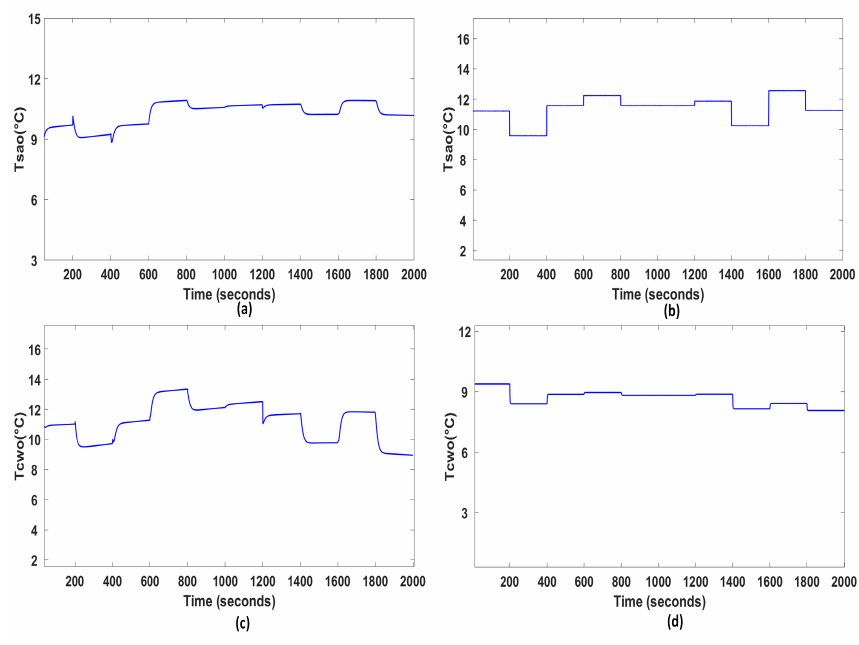
Figure 11. Output temperature results of, ( a ) supply air (Tsao) from the PID controller for the combination of steps reference of Zone 1 and Zone 2, ( b ) supply air (Tsao) from SMC for the combination of steps reference of Zone 1 and Zone 2, ( c ) cooling coil water outlet temperature (Tcwo) from the PID controller for the combination of steps reference of Zone 1 and Zone 2 and ( d ) cooling coil water outlet temperature (Tcwo) from SMC for the combination of steps reference of Zone 1 and Zone